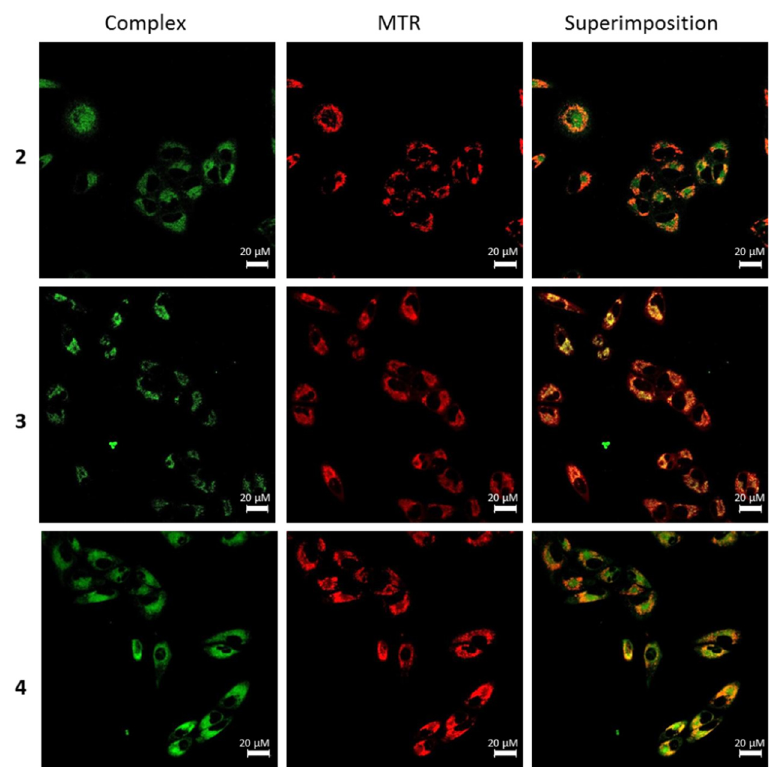
Figure 8. Fluorescence confocal microscopy images in A549 cells incubated with complexes 2 , 3 , 4 (green, irradiated at 458 nm) and stained with MTR (red, irradiation at 598 nm).